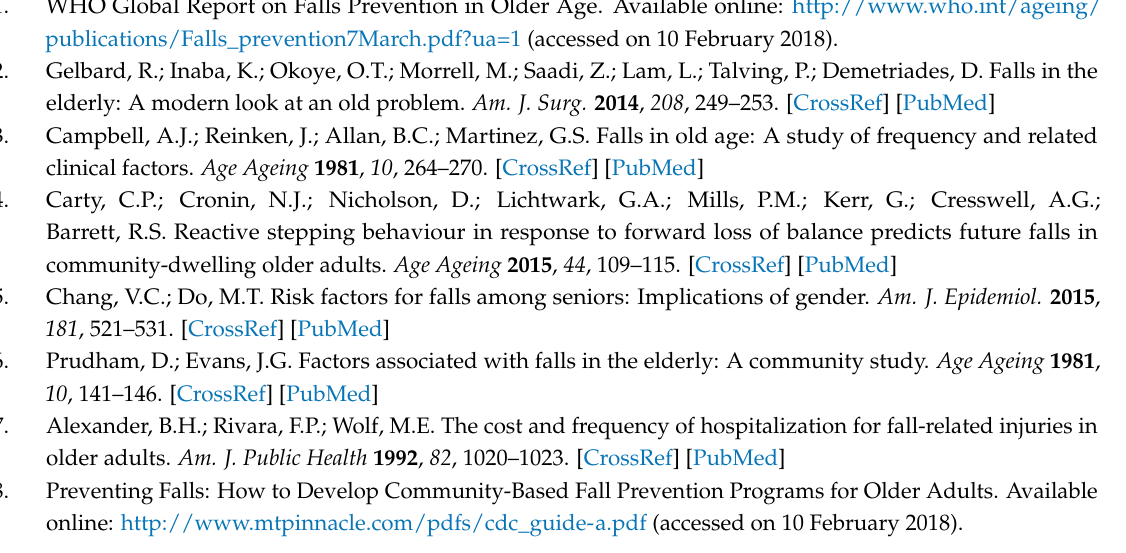
Figure S1: Network of interventions to prevent falls in the elderly. Figure S2: Judgments of risk for 7 items of bias in all 49 included studies. Figure S3: Risk summary of 49 studies included in NMA by item and article. Figure S4: Ranking of intervention strategies based on probability of their effects on outcome of falls (Rankogram). Figure S5: Surface under the cumulative ranking curve (SUCRA) probabilities diagram. Figure S6: Pooled odds ratios for fall incidence by Bayesian NMA and pairwise meta-analysis. Figure S7: Benchmark effect diagram. Figure S8: Table S1: Search strategy used for PubMed. Table S2: Characteristics of studies included in the NMA. Table S3: Contribution of direct evidence to the network. Table S4: Changes in rank based on SUCRA and Mean rank of 11 comparator groups after excluding studies with high-risk biases or unclear